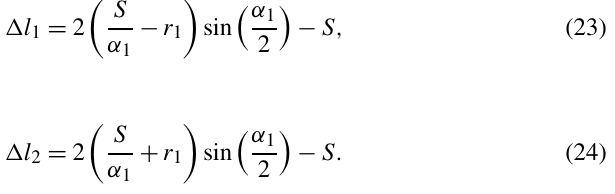
Figure 5. The model of the series